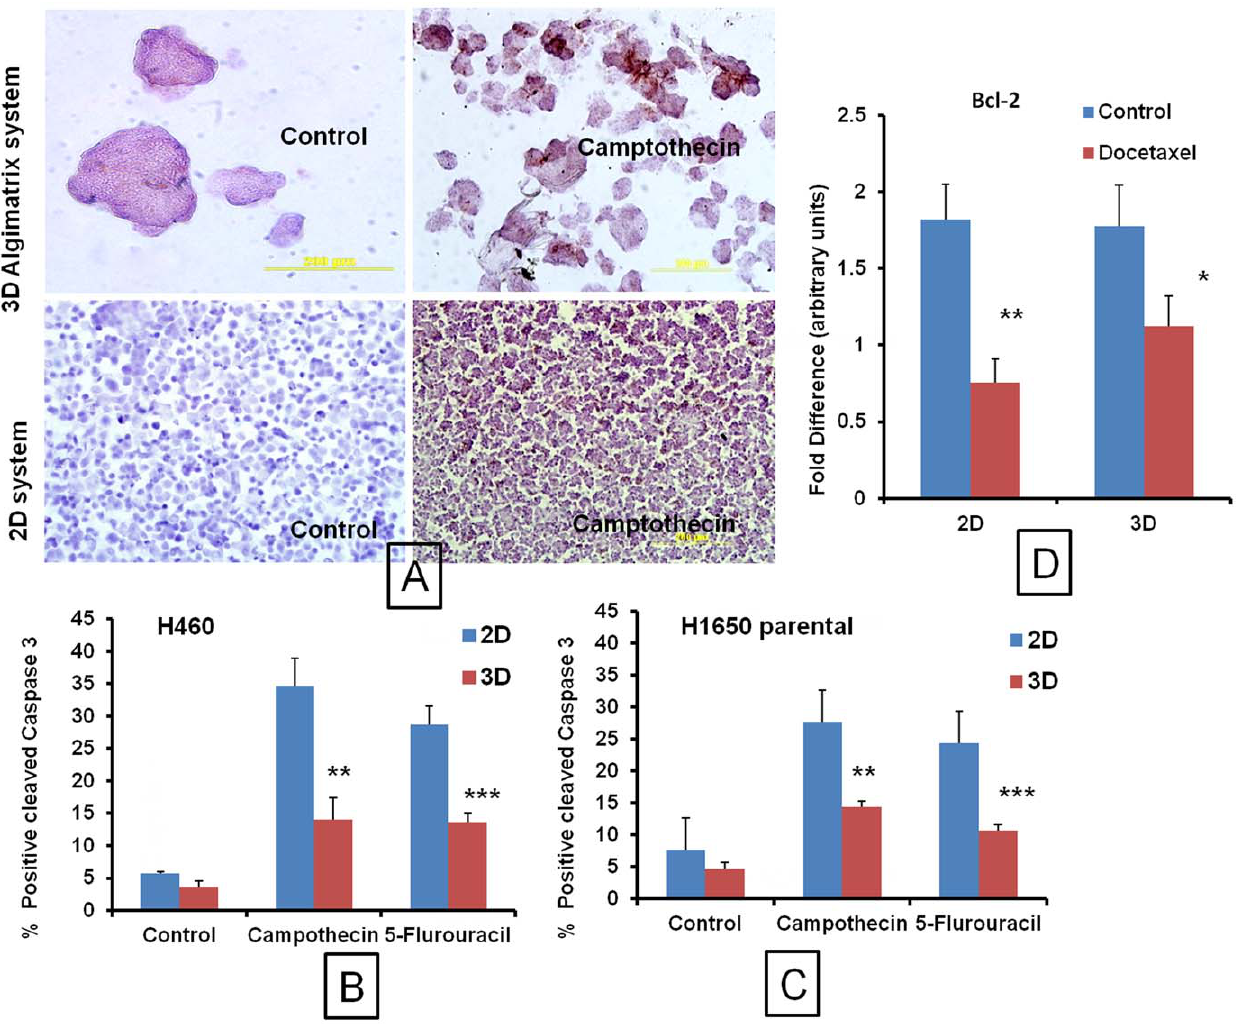
Figure 7. Immunohistochemistry and RT-PCR analysis. A) Representative images of immunohistochemistry of H1650 parental cells or spheroids grown in 2D and 3D culture systems for cleaved caspase positive cells and effect of Camptothecin and 5-Fluorouracil on cleaved caspase expression. Comparative Immunohistochemistry of B) H460 and C) H1650 parental cells or spheroids grown in 2D and 3D culture systems for cleaved caspase 3 positive cells. D) RT-PCR analysis of RNA isolated from 2D and 3D culture systems and effect of Docetaxel on Bcl-2 expression in H460 cells. The IC 50 concentration of Docetaxel 2D: 1.41 m M and 76.27 m M were used for treatment. Each data point is represented as mean 6 sem (n=3). * , 0.05, **P , 0.01 and ***P , 0.001 Vs respective 2D